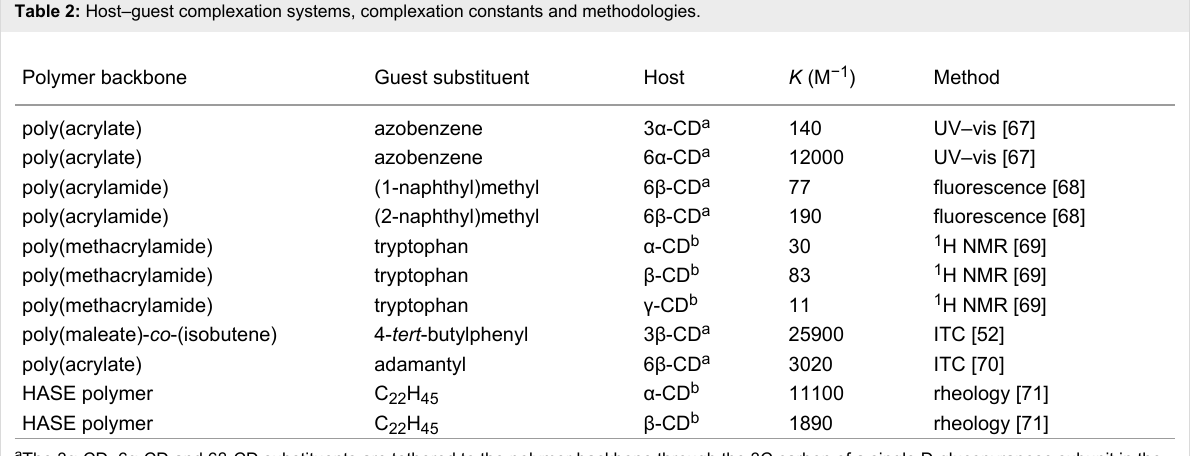
Table 2: Host–guest complexation systems, complexation constants and